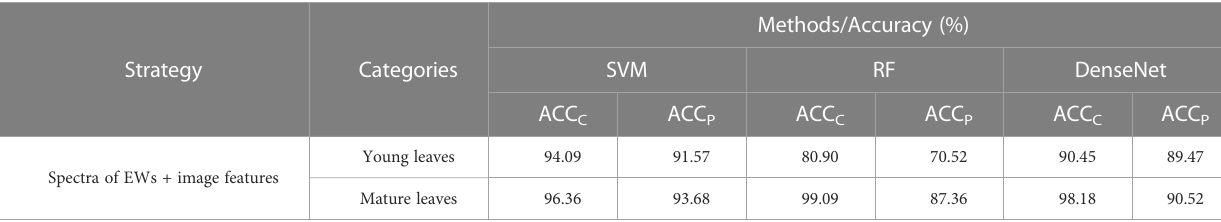
Spectra of EWs + image